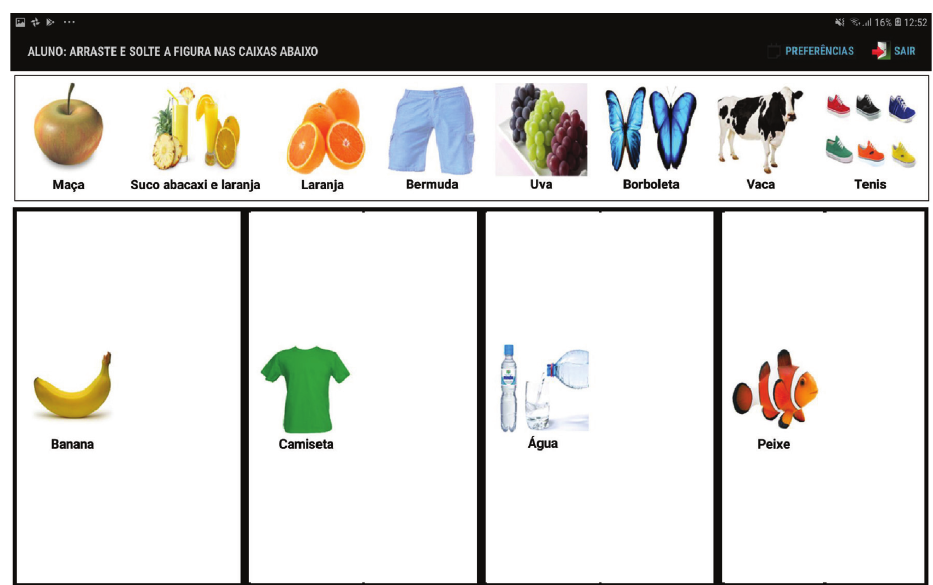
Figure 9: The drag-and-drop